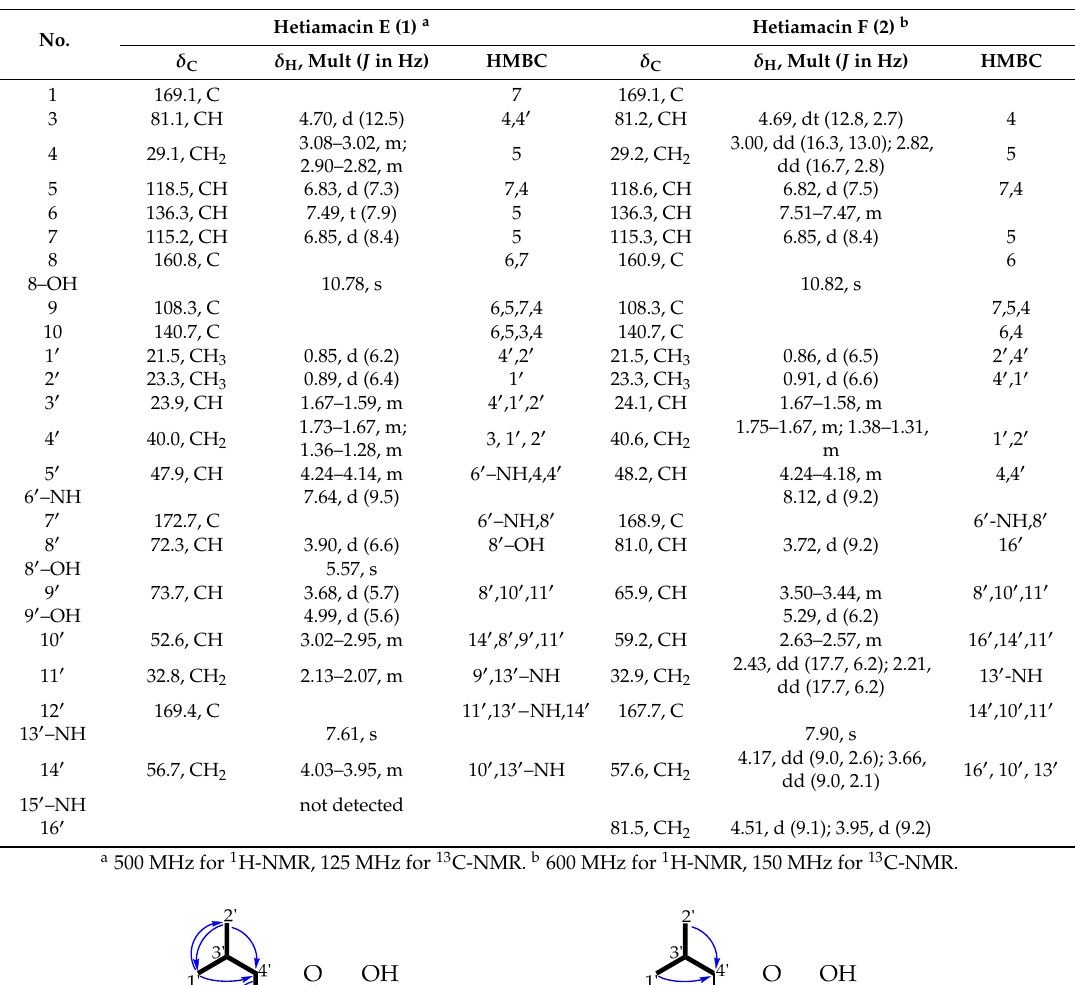
Table 1. NMR data of hetiamacin E ( 1 ) and hetiamacin F ( 2 ) in DMSO- d 6.